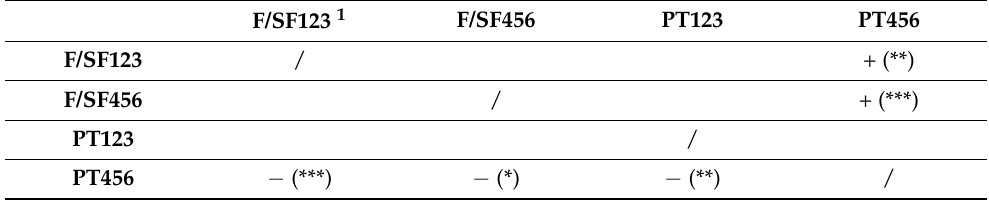
Table 13. The comparison of player levels’ influence on pacing strategy between Q1 and Q2.